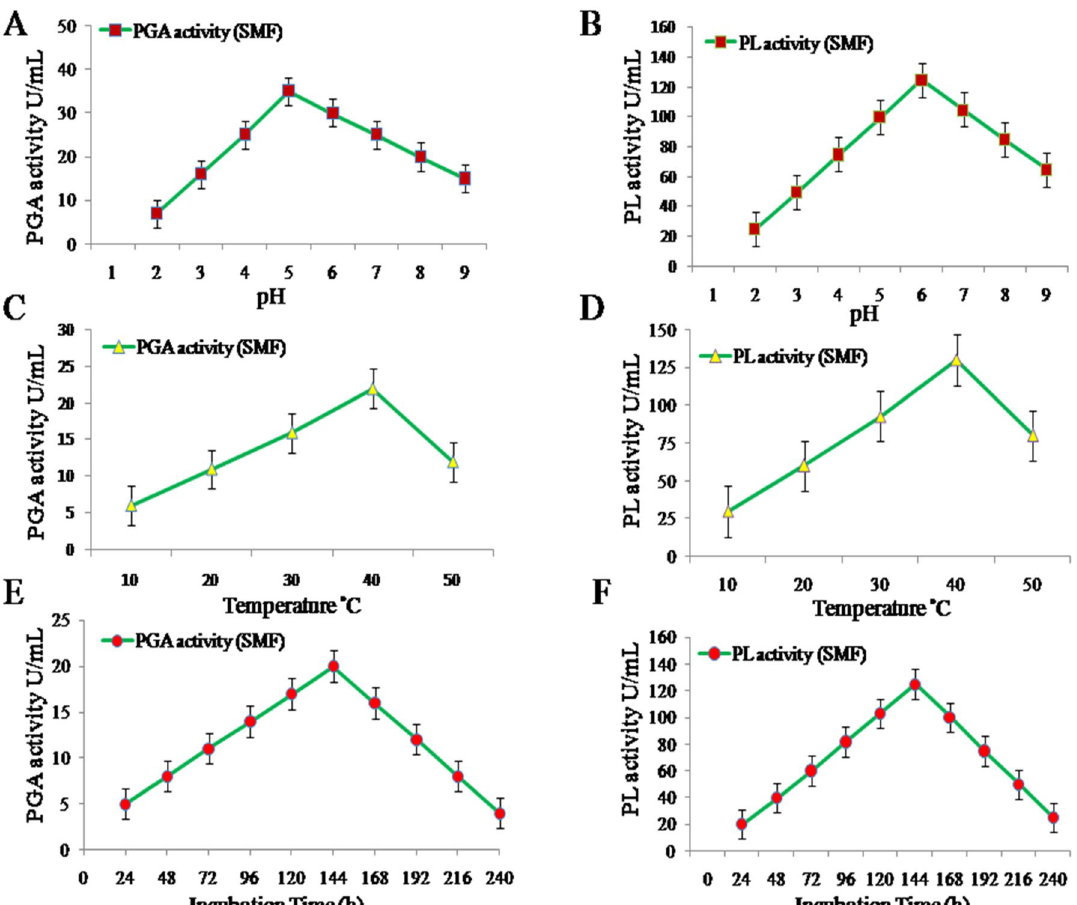
Figure 1. Effect of pH, temperature and incubation time on PGA and PL production in SMF method. ( A ) pH on PGA production. ( B ) pH on PL production. ( C ) Temperature on PGA production. ( D ) Temperature on PL production. ( E ) Incubation time on PGA production and. ( F ) Incubation time on PL production. PGA polygalacturonase; PL pectin lyase; SMF sub-merged fermentation. Data was presented as mean ± SEM (n =